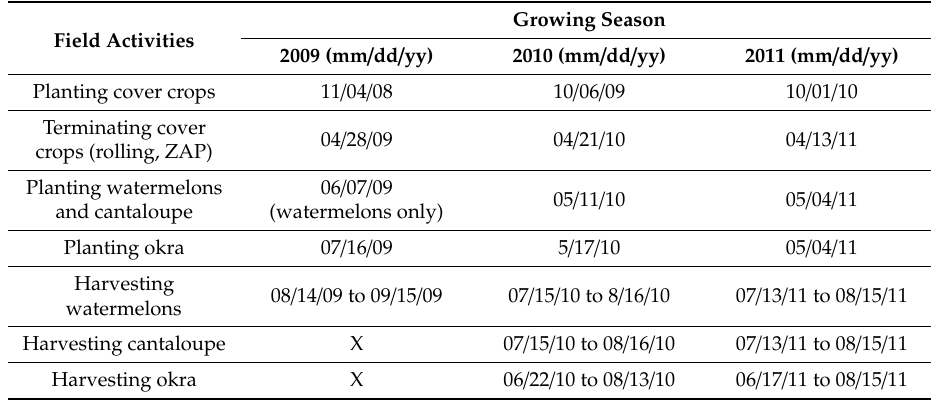
Table 1. Field operations at each growing season.